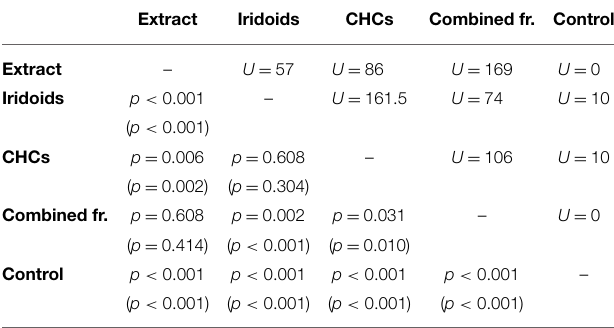
TABLE 5 | Statistical details for the pairwise comparisons of courtship duration toward extract, fractions, combined fractions, and control for L. boulardi .